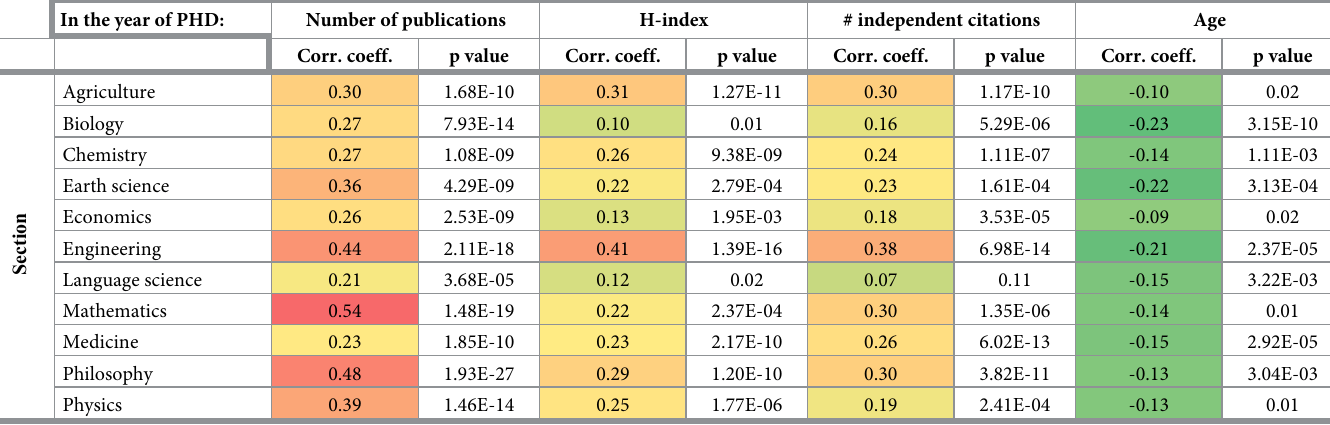
Table 1. Correlation between the number of publications ten years after obtaining the PhD. In the year of PHD: